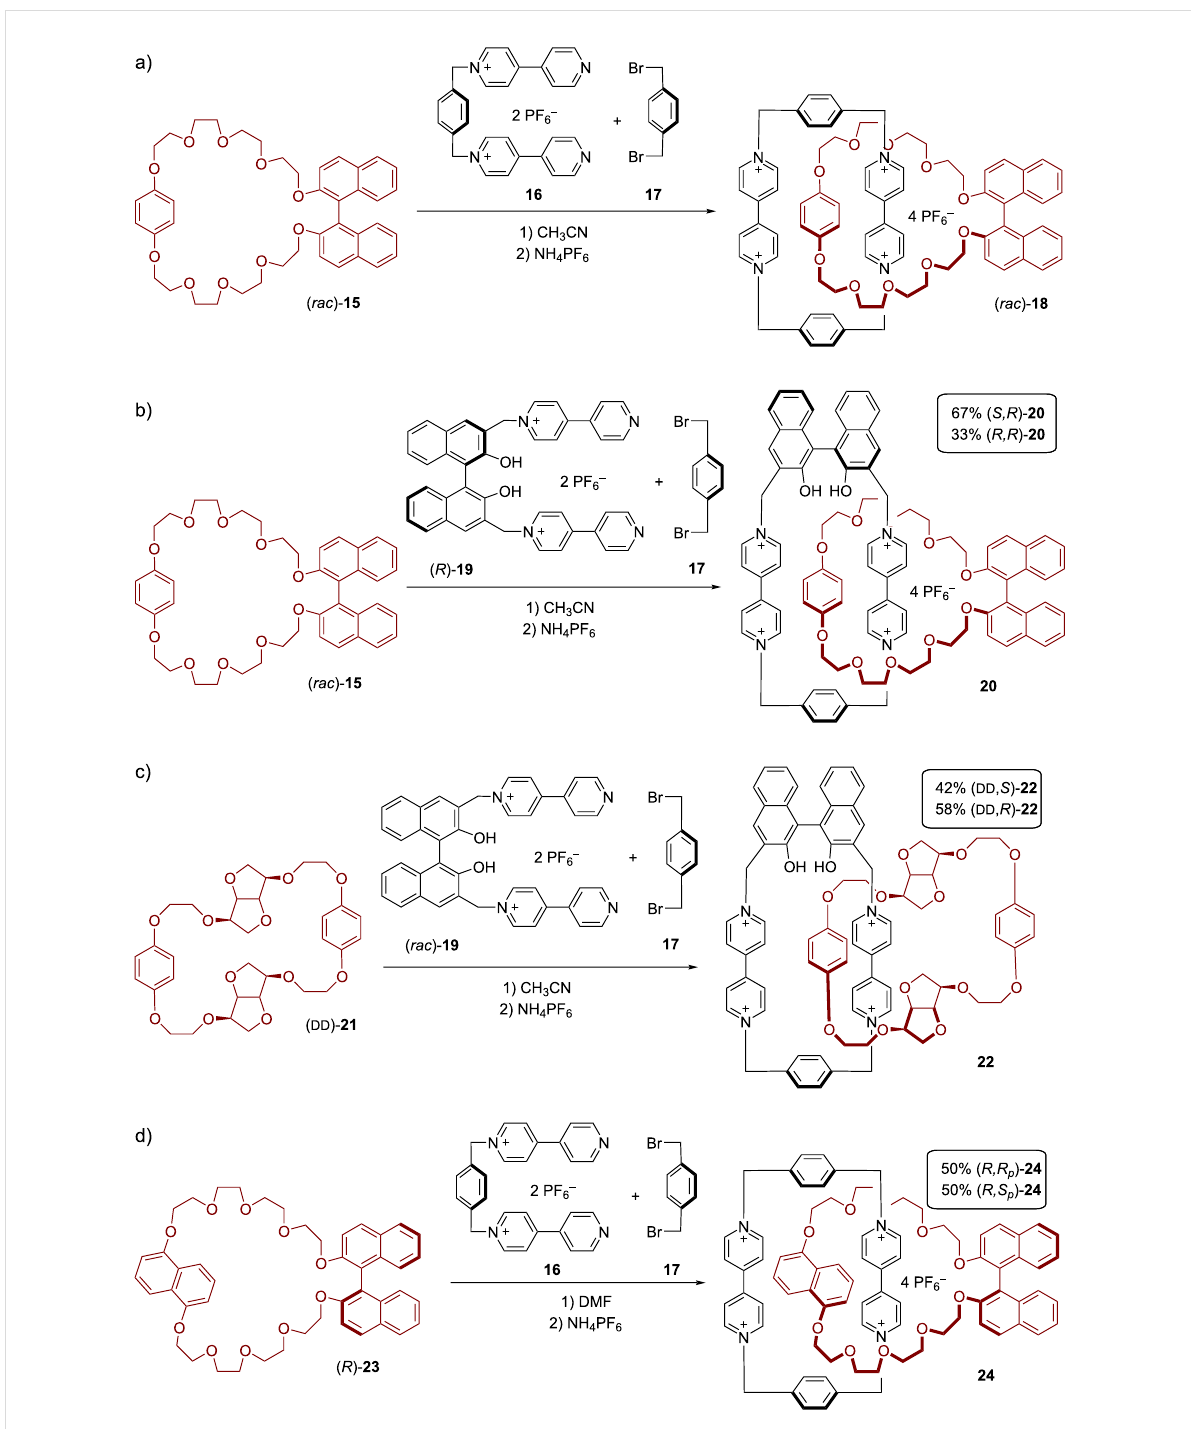
Figure 5: Synthesis of Stoddart´s BINOL-containing [2]catenanes 18 / 20 / 22 / 24 by π – π recognition.